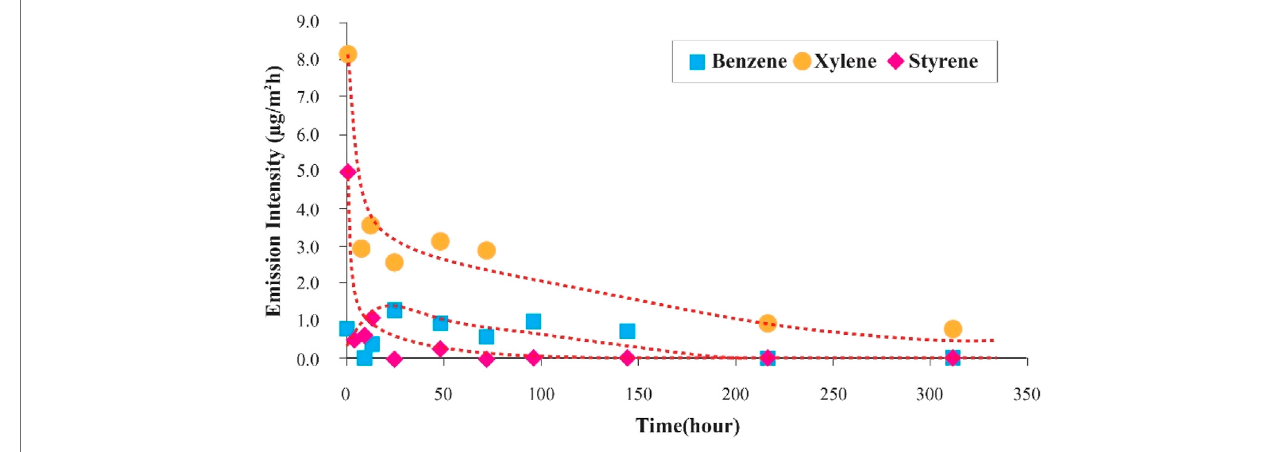
FIGURE 4 | Emission pattern of benzene, xylene, and styrene from wallpaper.